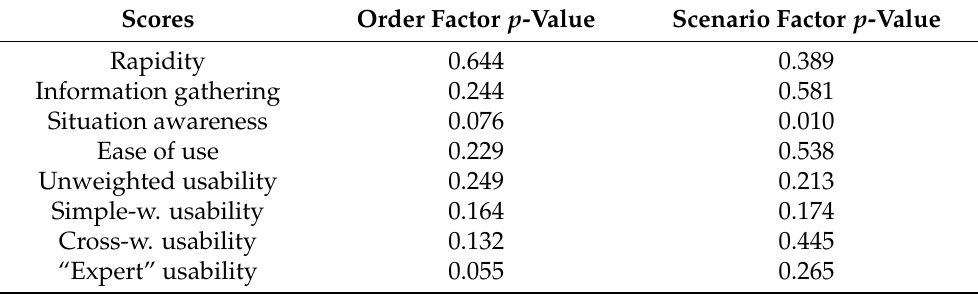
Table 4. HMD: repeated-measures ANOVA on quality factors and usability scores with interaction technique, scenario, and order